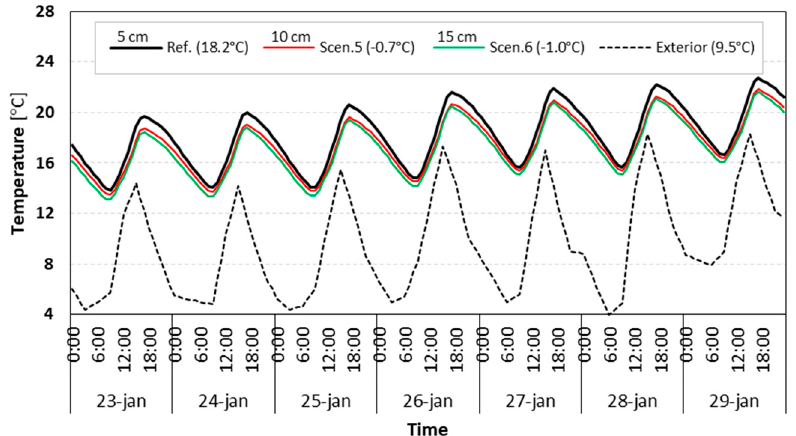
Figure 15. Influence of di ff erent storage wall thicknesses.